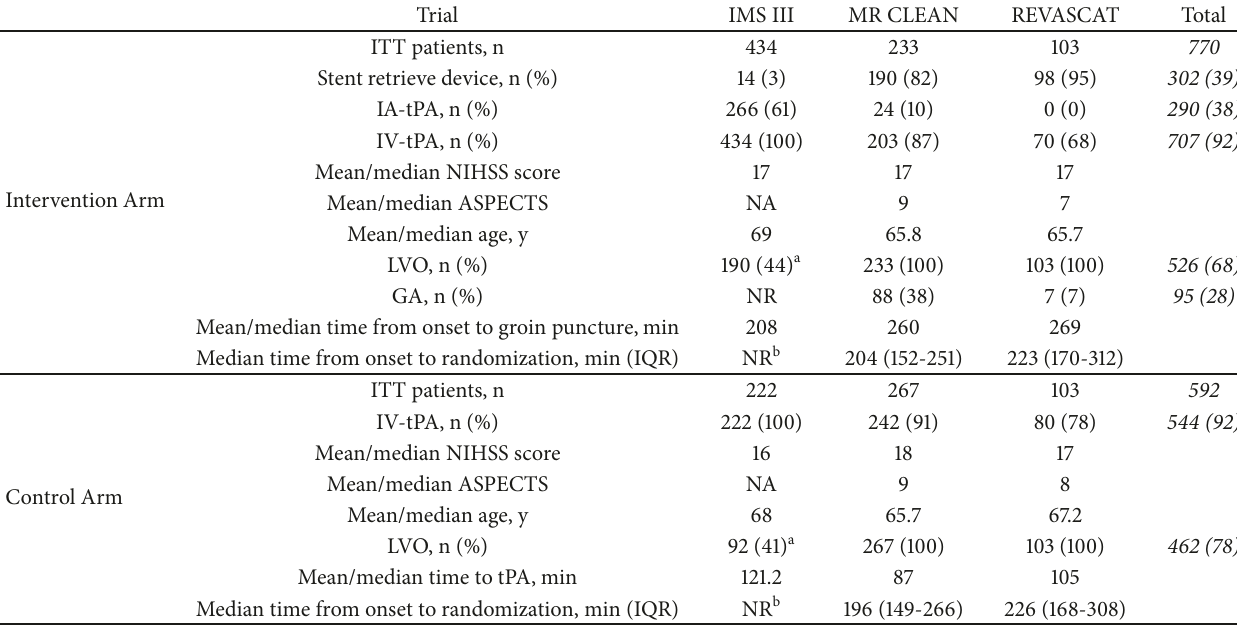
Table 2: Characteristics of intervention and control arms of included